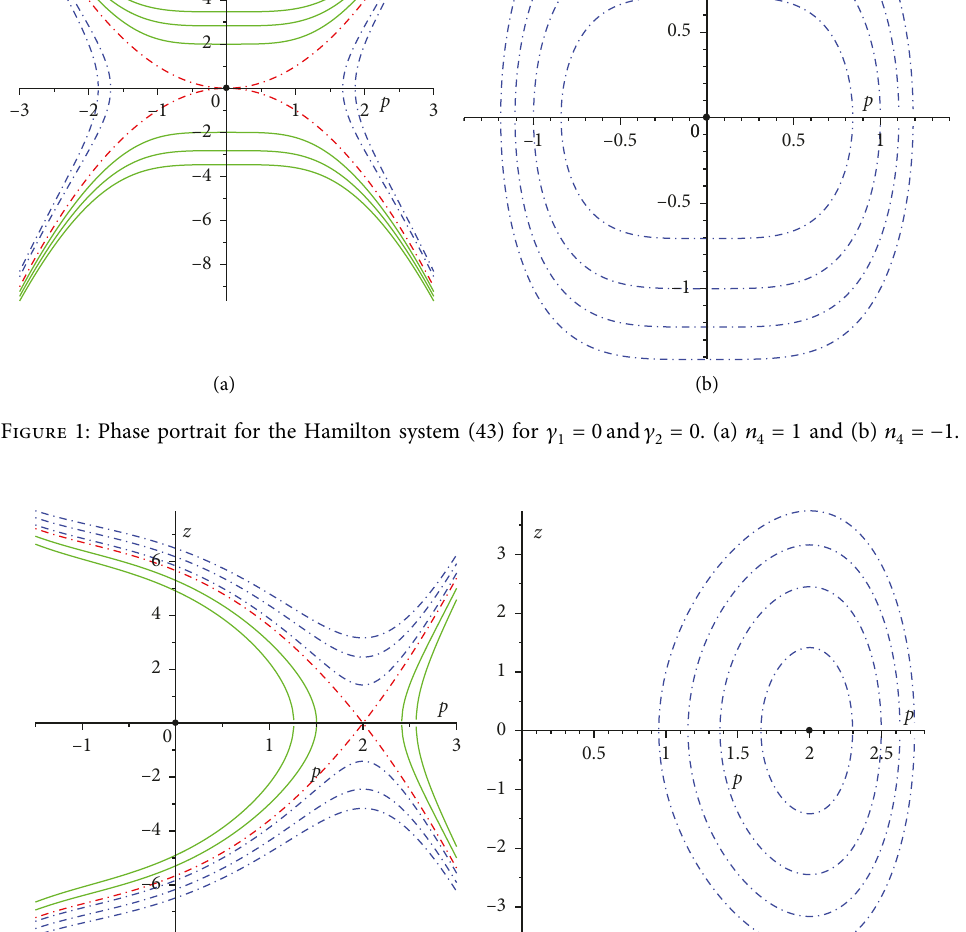
Figure 2: Phase portrait for the Hamilton system (43) for